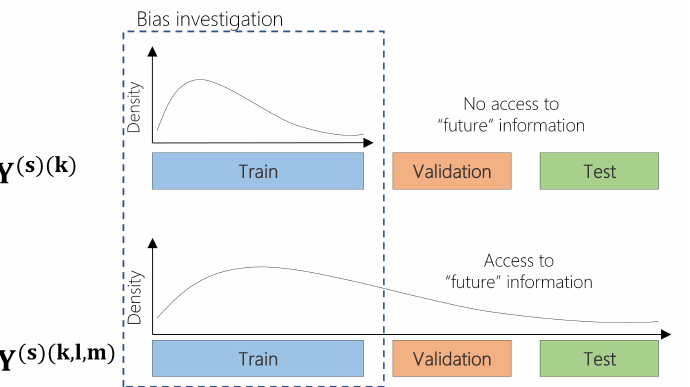
Figure 3. Two computational approaches of (N)SPI calculation. ( top ) (N)SPI calculation us- ing the training set (Y ( s )( k ) ), ( bottom ) (N)SPI calculation using the training, validation and test sets (Y ( s )( k , l , m )